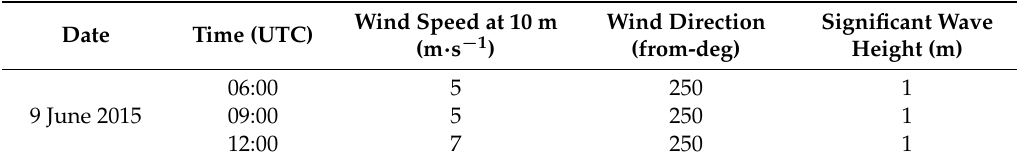
Table 1. Environmental Conditions during the MOS Sweeper experiment.